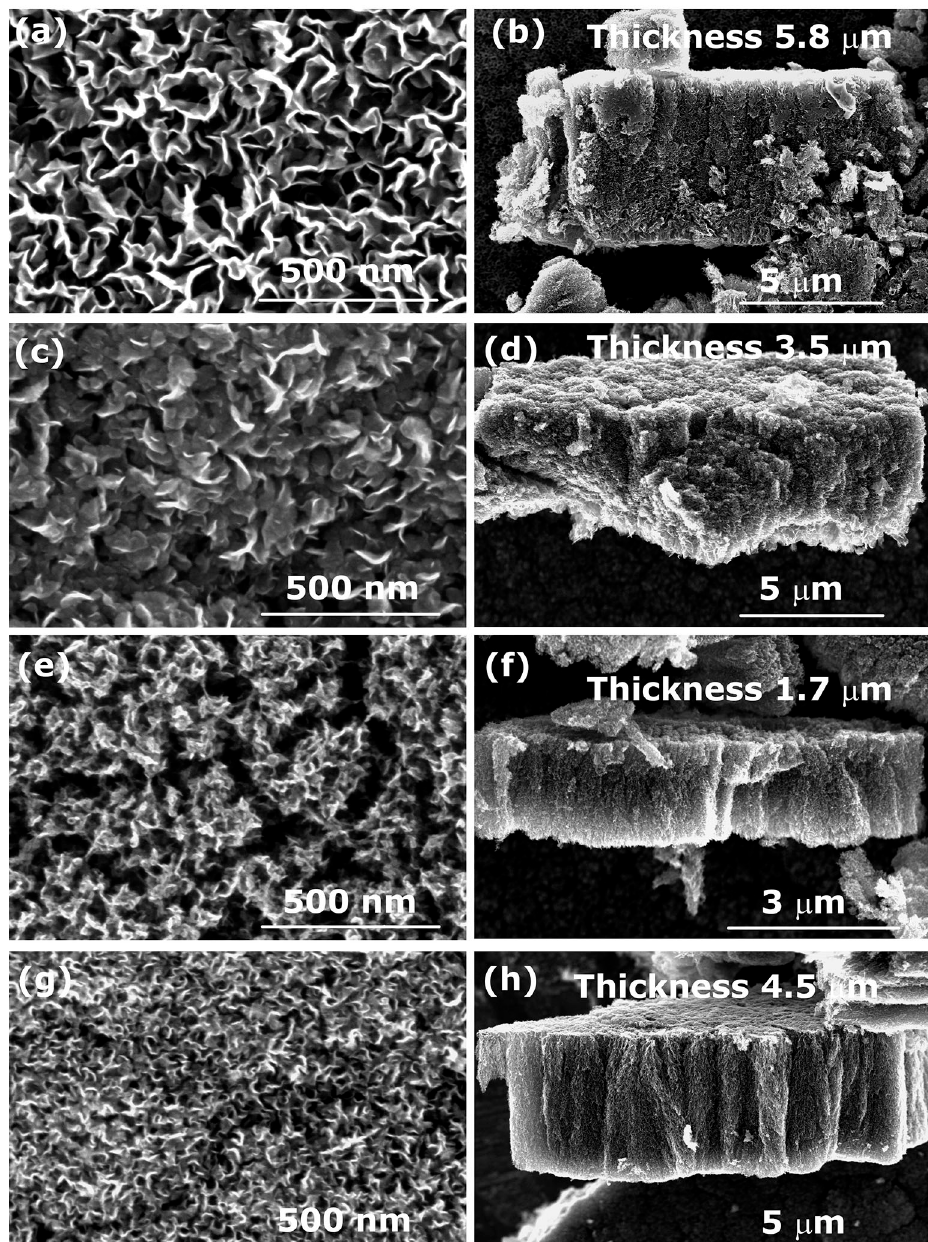
Figure 8. SEM images of carbon nanostructures (left) and their cross-section (right) synthesized from the aromatic PS polymer in plasma created in: ( a , b ) O 2 , ( c , d ) H 2 , ( e , f ) N 2 , and ( g , h ) CO 2 gas. Deposi- tion time was 60